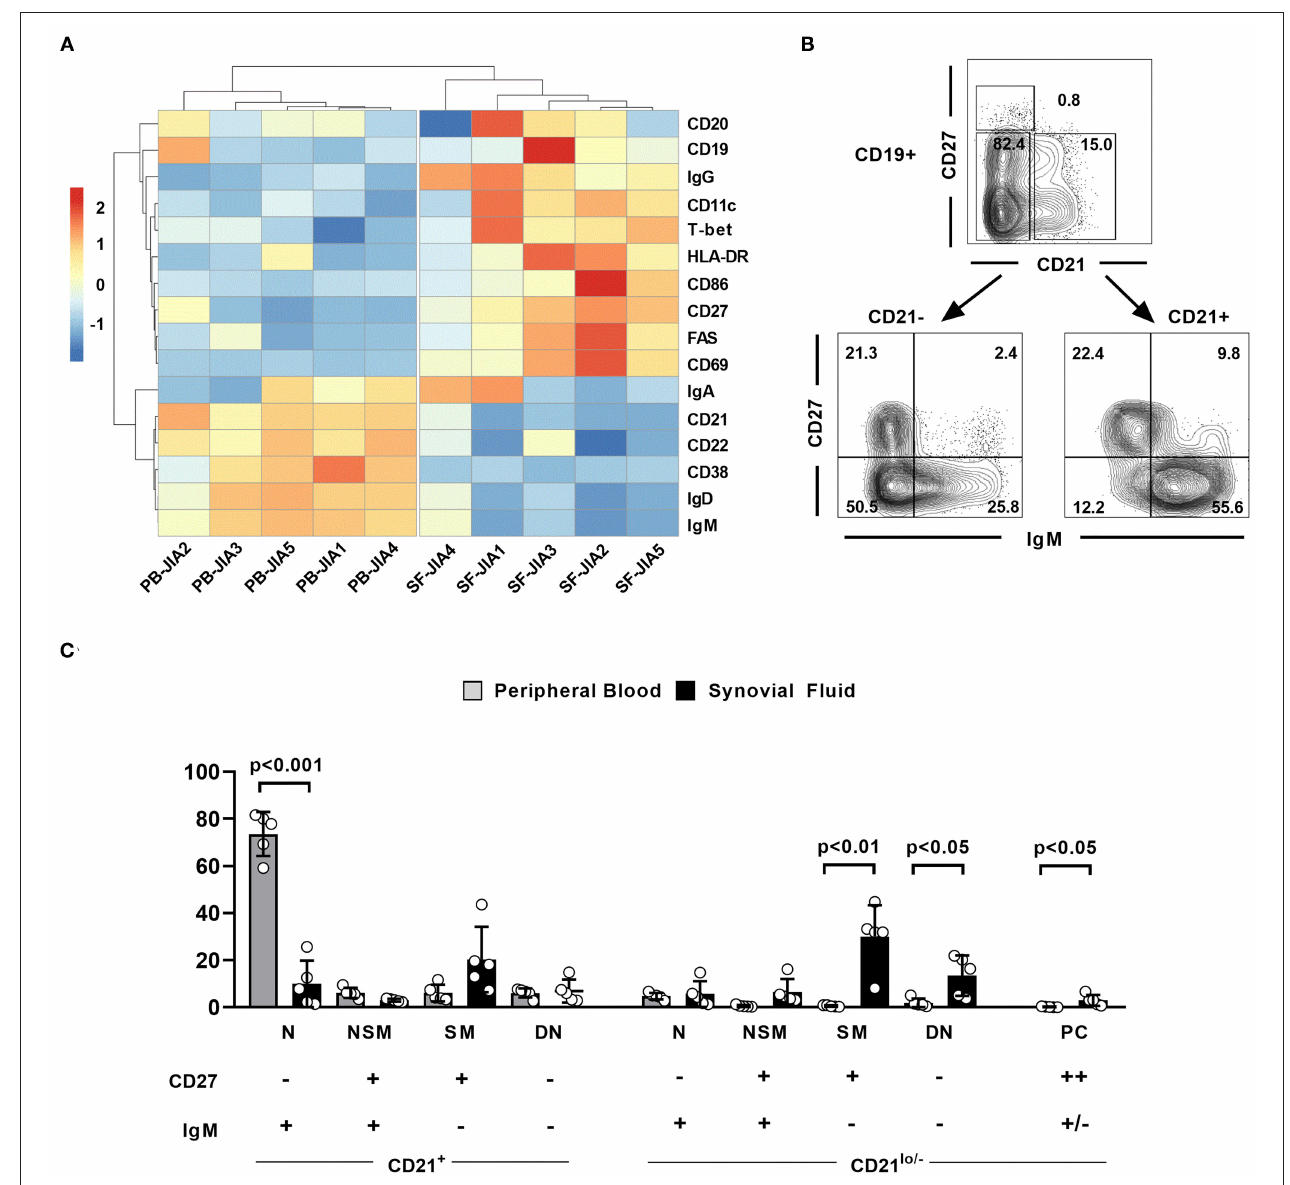
FIGURE 2 | The extended phenotype of synovial fluid B cells in JIA patients. (A) Hierarchical cluster analysis of mean fluorescence intensities of different markers in CD19 + peripheral blood (PB) and synovial fluid (SF) B cells from five JIA patients assessed by flow cytometry. (B) Flow cytometric gating strategy of different SF B cell populations. (C) Distribution of different B cell populations within CD19 + PB and SF B cells of five JIA patients. Groups were compared using paired Student’s t -test. Bars represent mean frequency with standard deviation and circles individual data points. N, Naïve; NSM, non-switched memory; SM, switched memory, DN, double negative; PC, plasma